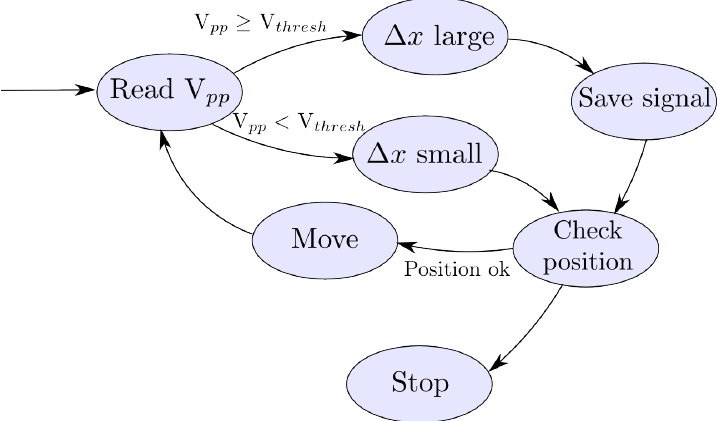
Figure 6. Schematic representation of the scanning algorithm for the topographical mapping of the GESA coating’s elastic